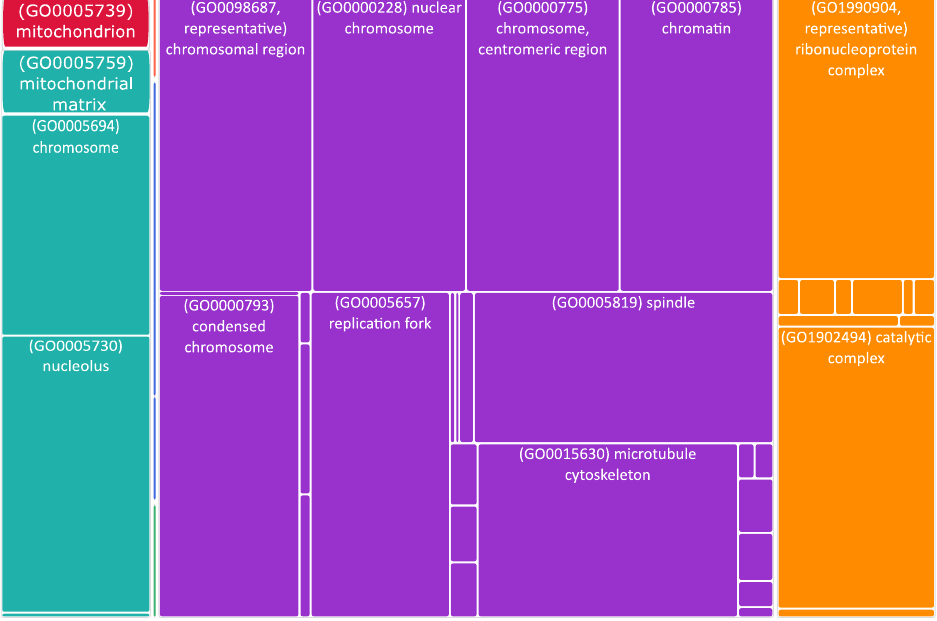
Figure 4. Tree map of upregulated genes in the stage 4 + 4S. Each rectangle is a single cluster representative. The representatives are joined into “superclusters” of loosely related terms, visualized with different colors. Sizes of the rectangles are adjusted to reflect the p -value of the GO term (“cellular component”). Most representative terms are indicated. Cytoskeleton and mitochondria are enriched terms.